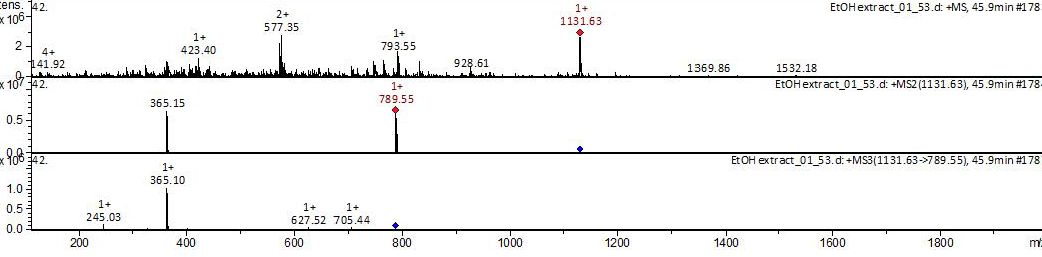
Figure 7. CID (collision-induced dissociation) spectra of ginsenoside Rb1 from wild ginseng (Russia), m / z 1131.63.